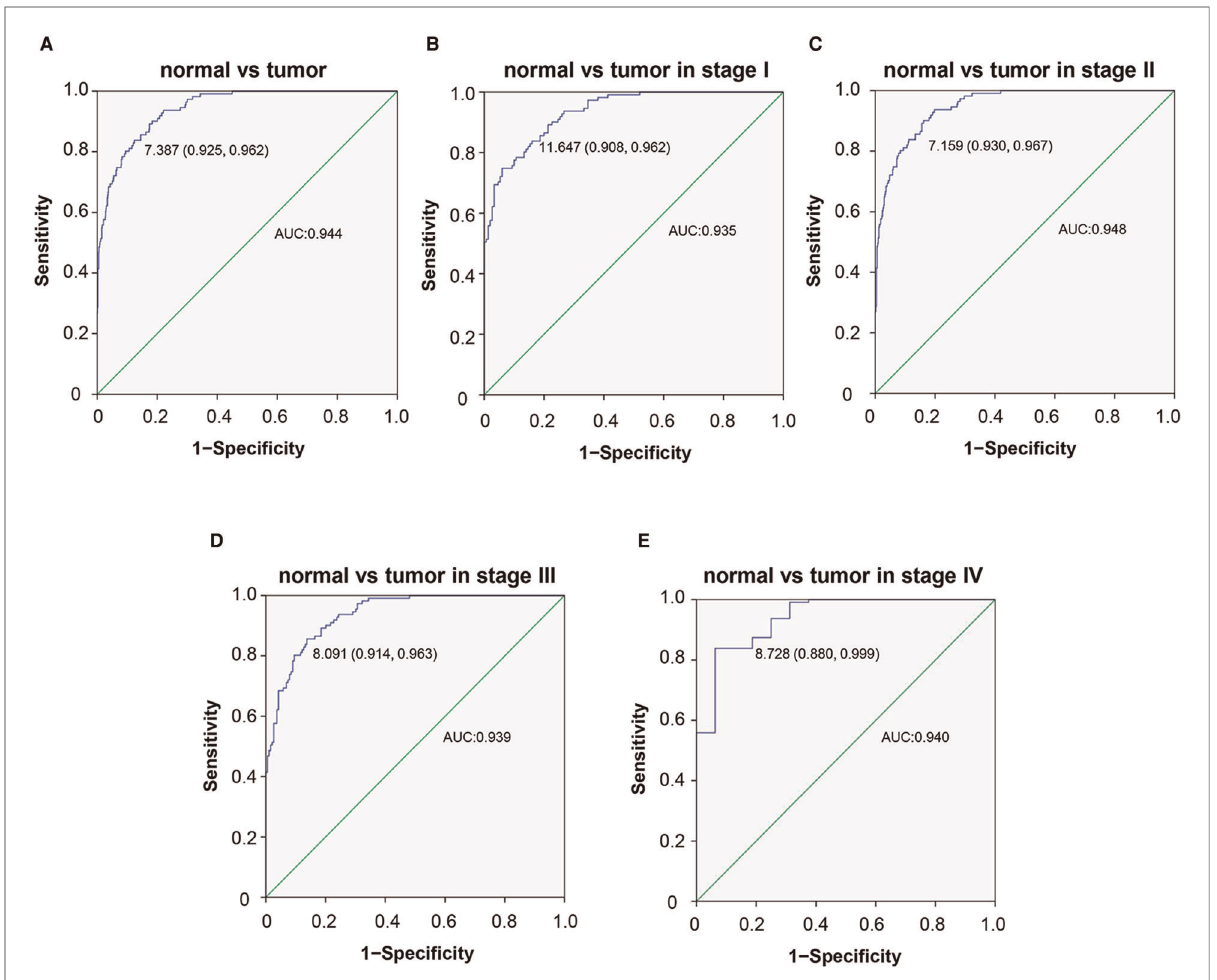
FIGURE 4 Diagnosis value of CCDC69. The ROC curve of normal tissues and BC ( A ), and subgroup analysis of stage I ( B ), II ( C ), III ( D ), and IV ( E